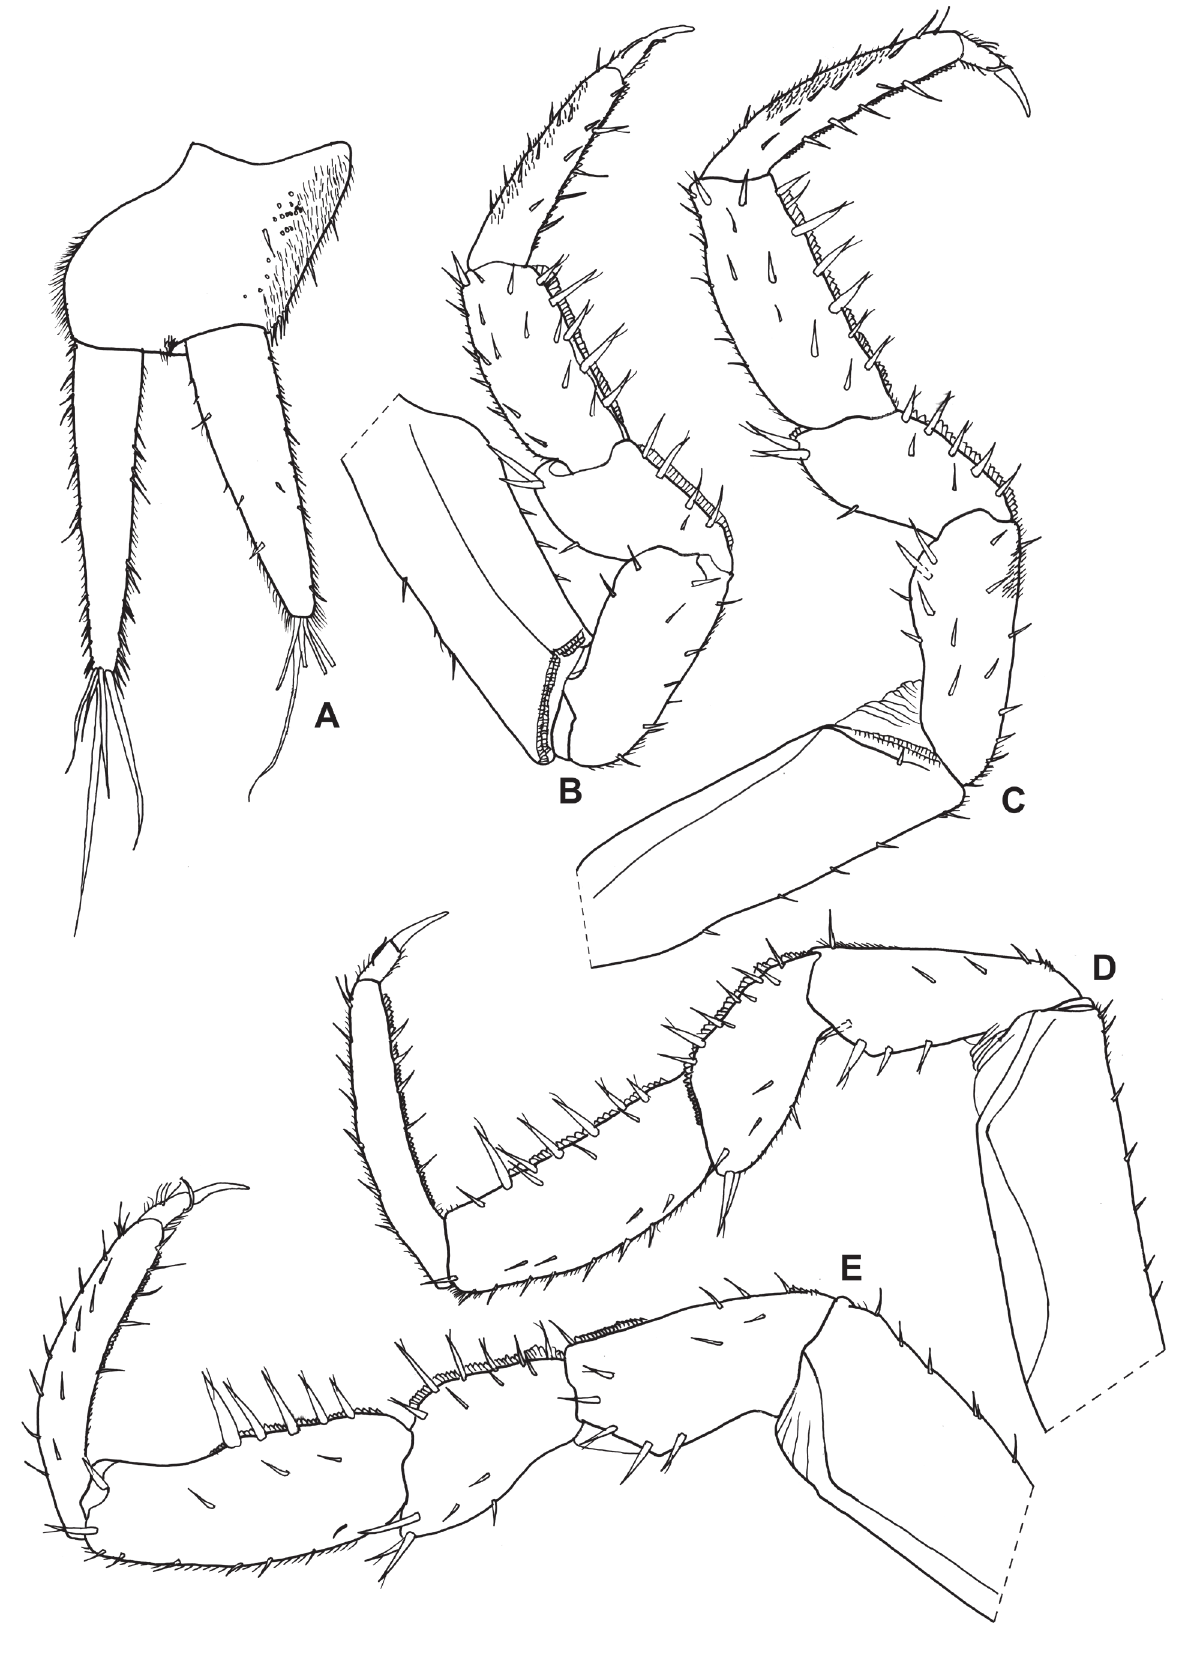
Figure 4. Xangoniscus odara n. sp. (male paratype). A, uropod; B, pereopod 1; C, pereopod 2; D, pereopod 3; E, pereopod